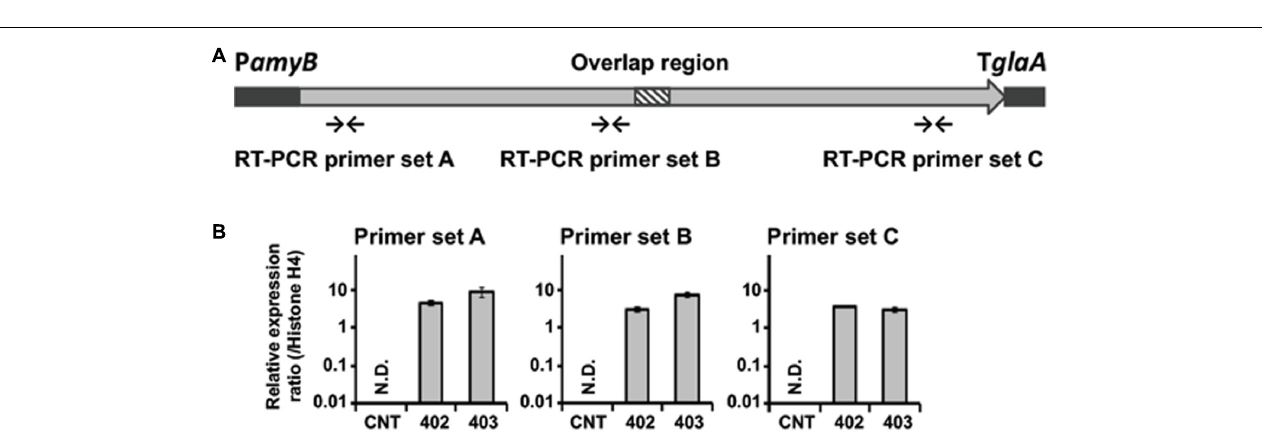
FIGURE 2 | Strategy for reconstruction of the NRPS gene in Aspergillus oryzae. The first step (top) is the introduction of the front half of the NRPS gene into the A. oryzae genome. The second step (middle) is the strategy used for marker recycling using the Cre/ loxP system. The third step (bottom) is integration of the rear half of the NRPS gene into the A. oryzae NRPSfh strain, resulting in reconstruction of the NRPS gene in A. oryzae .